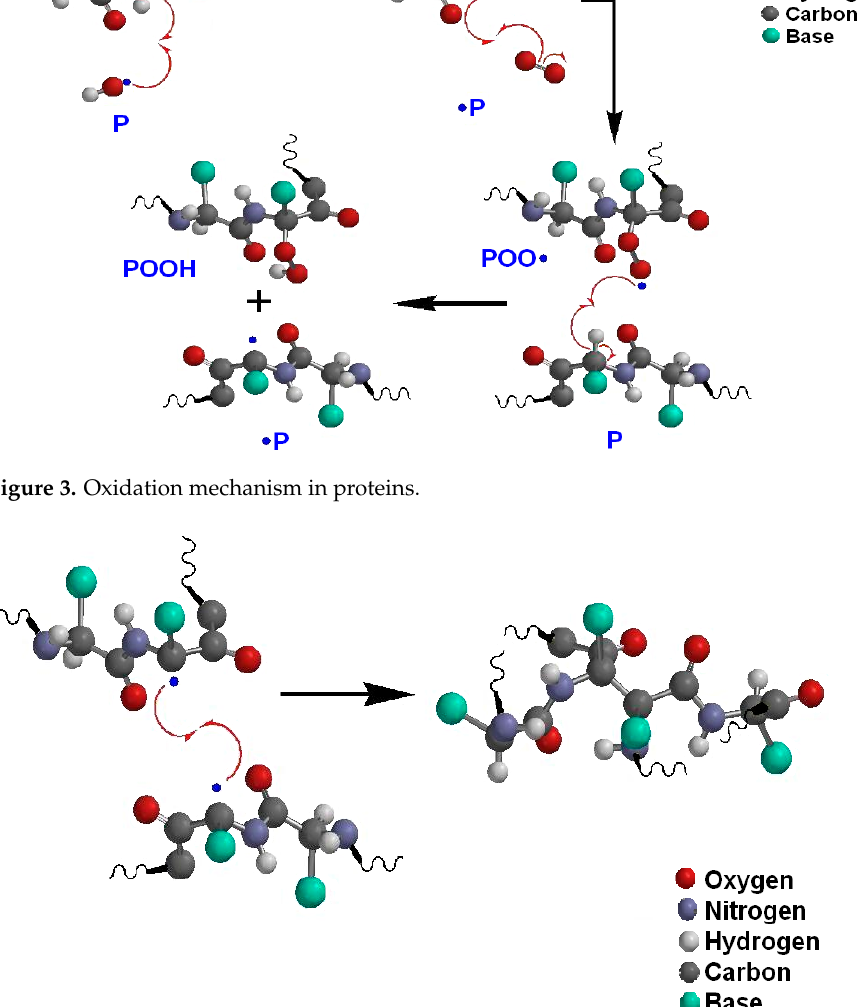
Figure 4. The cross-linking of amino acid chains by the reaction of two protein